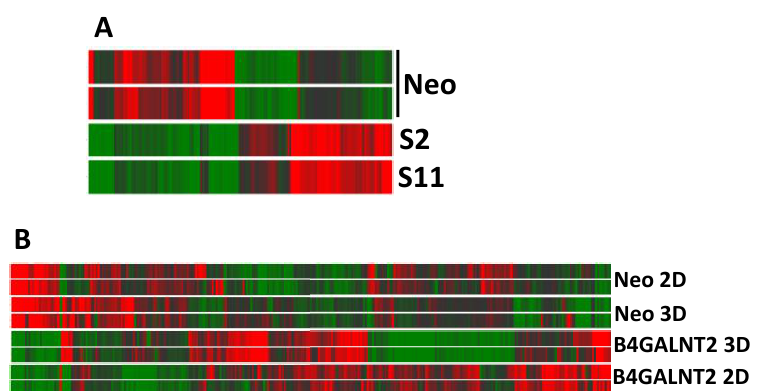
Figure 5. Heatmaps of gene expression analysis. ( A ) B4GALNT2-expressing and control Neo LS174T cells grown in standard 2D conditions. ( B ) Cells grown in 3D conditions or in standard 2D conditions. High and low expression was normalized to the average expression across all samples. Di ff erences were analyzed by the moderated t -test. Corrected p -value cut-o ff : 0.15; multiple test correction used: Benjamini–Hochberg. Table 2. Pathways modulated by B4GALNT2